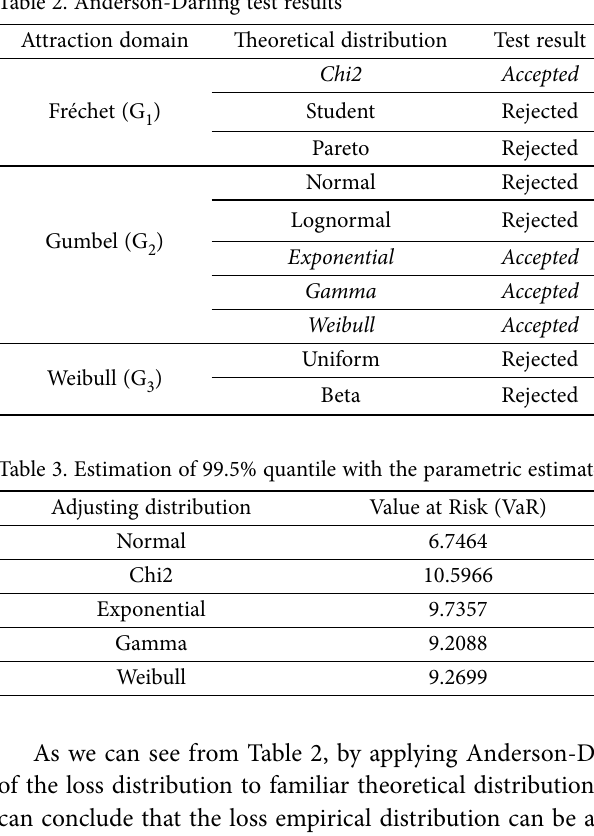
Fig. 2. Testing the normality of the historical sample